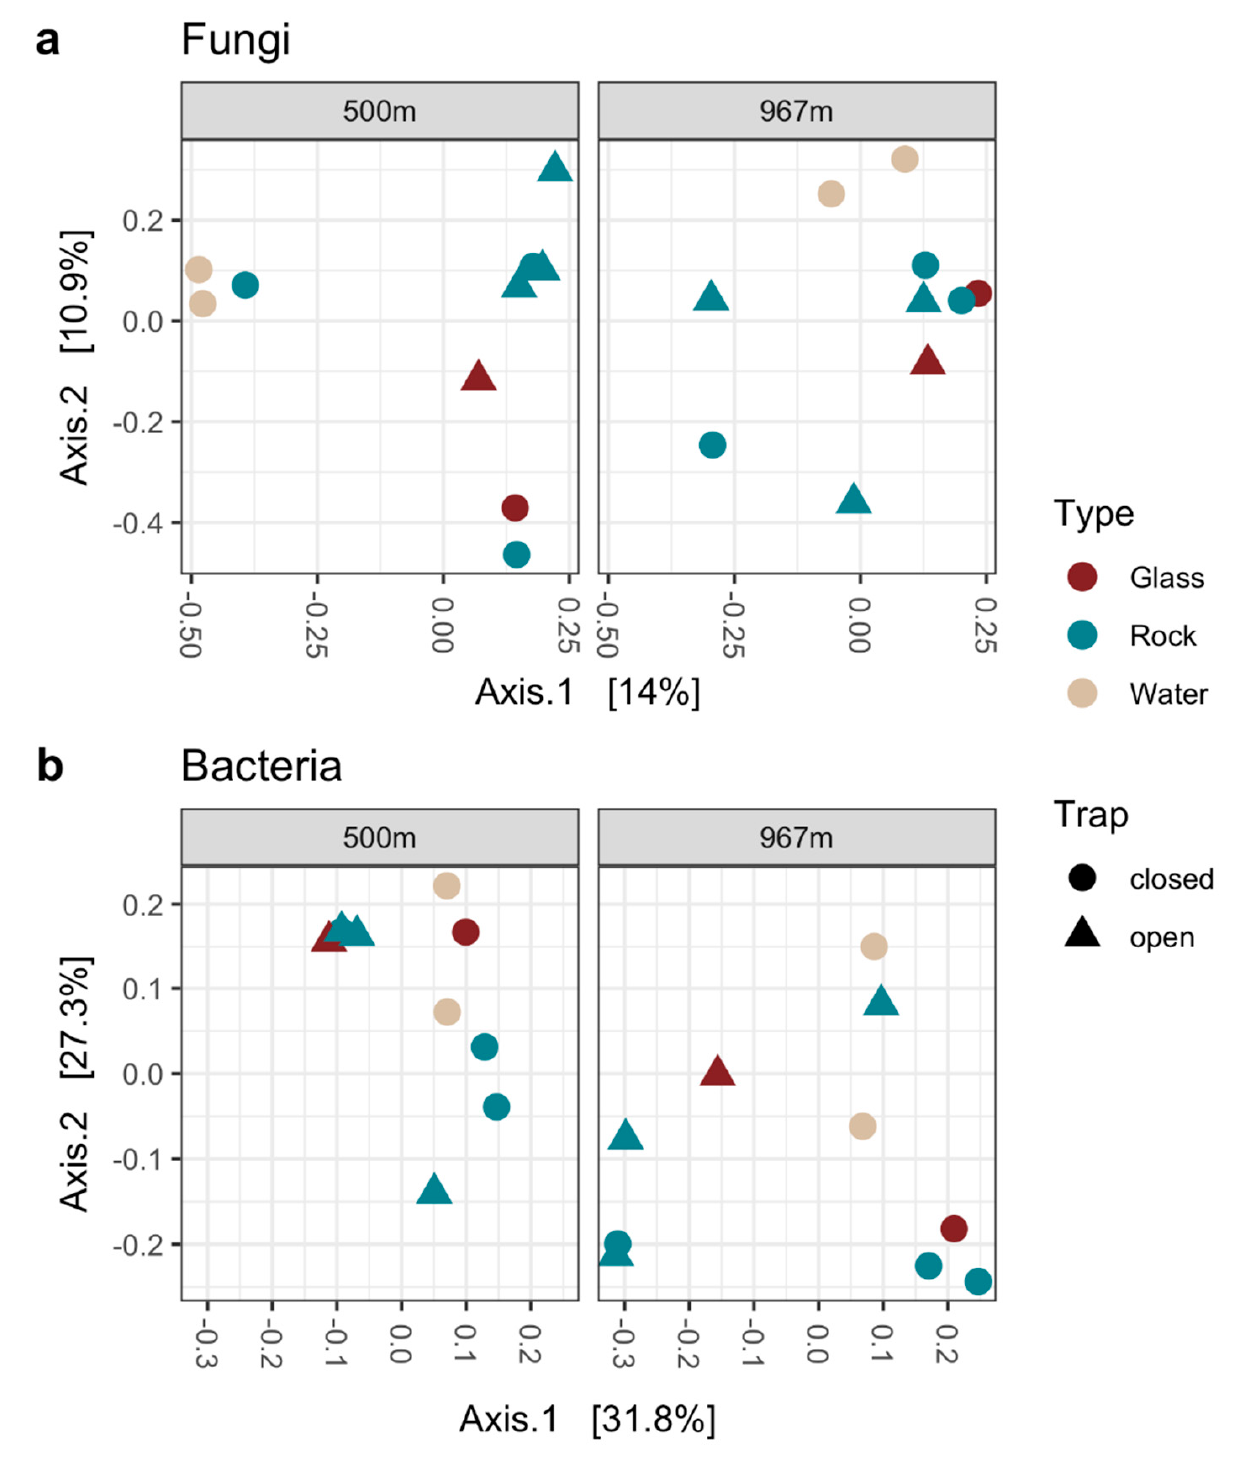
Figure 11. Fungal ( a ) and bacterial ( b ) community differences visualized with PCoA using the Bray–Curtis dissimilarity model. The PCoA was built from normalized count data. Axis 1 and 2 explains 14% and 10.9% of the variance for the fungal communities, respectively ( a ), and 31.8% and 27.3% of the variance for the bacterial communities, respectively ( b ).